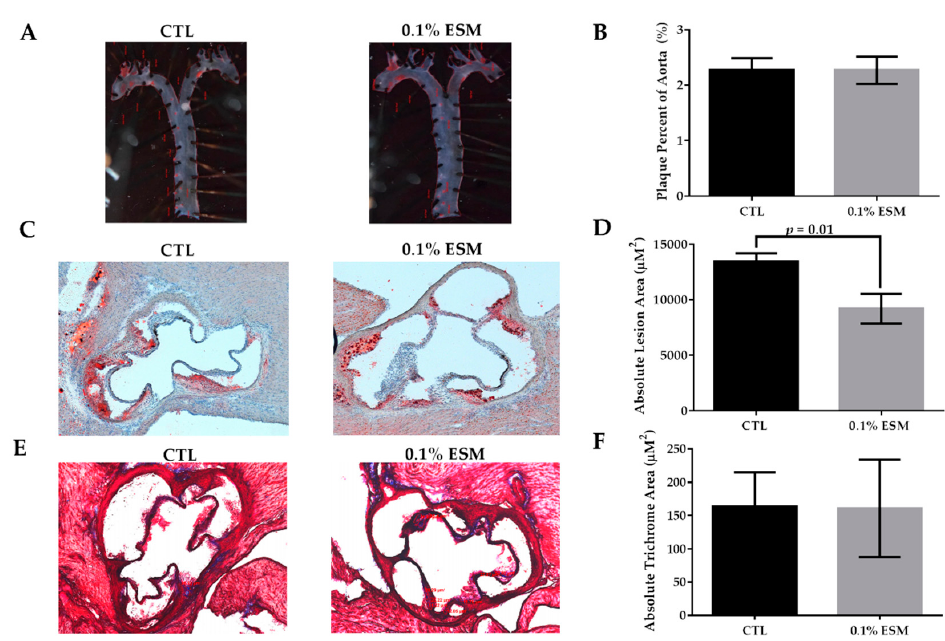
Figure 2. E ff ect of ESM on measures of atherosclerosis. Representative images of oil red O (ORO)-stained aortas from each group after eight weeks on a HFD with or without ESM ( A ) and the respective quantification of ORO-stained aortas, as percentage lesion area of the aorta ( B ). Representative images of ORO-stained aortic roots ( C ) and Masson’s trichrome stained aortic roots ( E ) from each group after 8 weeks of respective diets. Aortic root images were captured using a total of 50 × magnification. Quantification of absolute lesion area ( D ) and absolute trichrome area ( F ) are shown. Values are reported as mean ± SEM ( n = 8–9 per group).